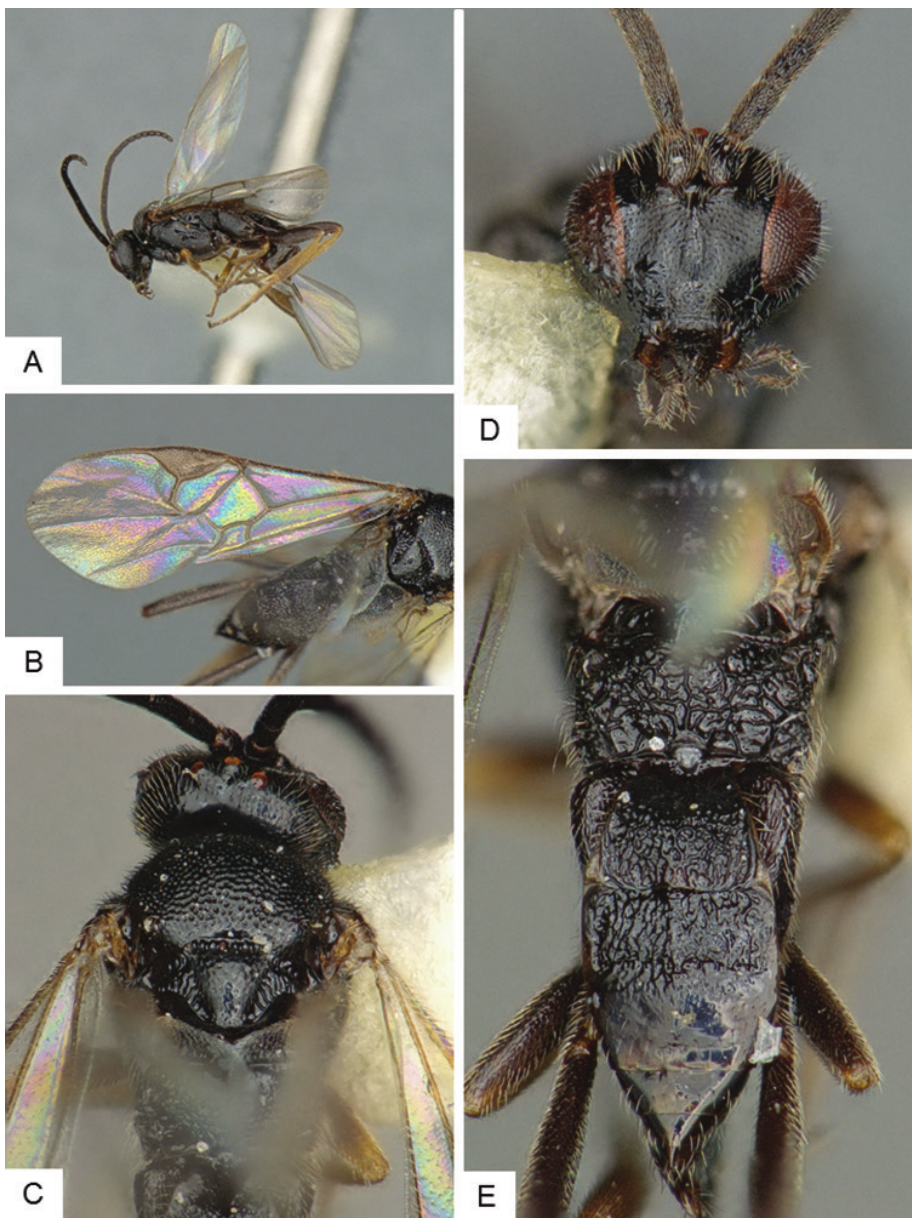
Figure 4. Cotesia hallii . A Habitus, lateral B Fore wing C Head and mesosoma, dorsal D Head, frontal E Metasoma,